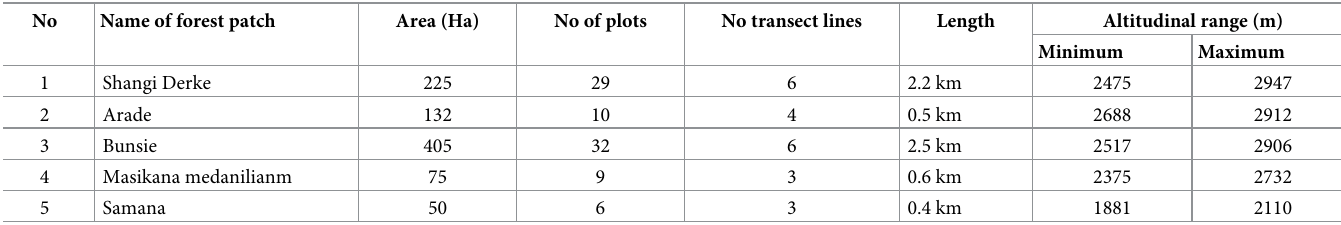
environmental data collection. Sampling sites were arranged along transects from the forest patches. The first transect and plot were selected purposely at one side of the forest by avoiding the forest edge. A total of 22 line transects (6 each in Shangi Derke and Bunsie forest patches, 4 in Aradie forest patch and 3 each in Masikana and Samana forest patches) were laid along elevation gra- dients. The number of plots per transect differs depending on the length of the transect (Table 2). The elevation between two consecutive plots and transect were 50 and 200 ma.s.l. apart in the forests, respectively. Accordingly, a total of 86 sampling plots of each measuring 900m 2 (30 m × 30 m) were taken from all 5 forest patches. Of which, 29 from Shangi Derke, 32 from Bun- sie, 10 from Aradie, 9 from Masikana Medihaniyalem and 6 from Samana forest patches were sampled. When a study mainly focuses on only woody species composition and diversity, research has mainly ignored studies on diversity and not included herbaceous species and rare species which are important to the understanding of a comprehensive list of plant species diversity in the study area. Therefore we have included the herbaceous species. Five smaller subplots of 2 � 2 m 2 , four at the corner, one at the center of the main plot were established for herbaceous plant species collection. In our study the overall cover of herbaceous species esti- mated by the average of individual cover values of species taken from the subplots (4 m 2). Vegetation data collection In each plot, all individual trees and shrubs with a diameter at breast height (DBH at 1.30 m above ground) > 2.5 cm were measured for DBH classes using a measuring tape. The height of woody individual species with > 3m height was measured using Suunto Clinometers. Within each plot, the cover/abundance values were estimated for all plant species. Three-column data tables were constructed in Microsoft Excel 2007 and saved in the CSV (comma delimited) for- mat. The first, second, and third columns represented by plots, species and abundance of spe- cies, respectively. After that, the percent cover of each species was transformed to ordinal scales and assigned to one of the nine cover-abundance classes according to the modified 1–9 Braun-Blanquet scale [29]. The scales for cover-abundance values are 1 � 0.1%, 2 = 0.1 to 1%, Table 2. Size, number of plots, transect and altitudinal range of forest patches. No Name of forest